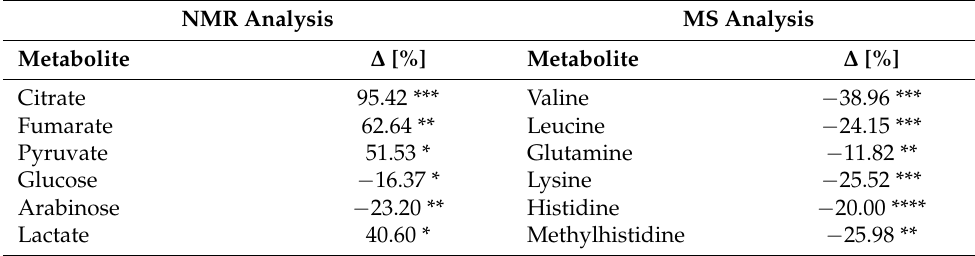
Table 4. Significantly changed metabolites in the serum of fa / fa and control rats at 40